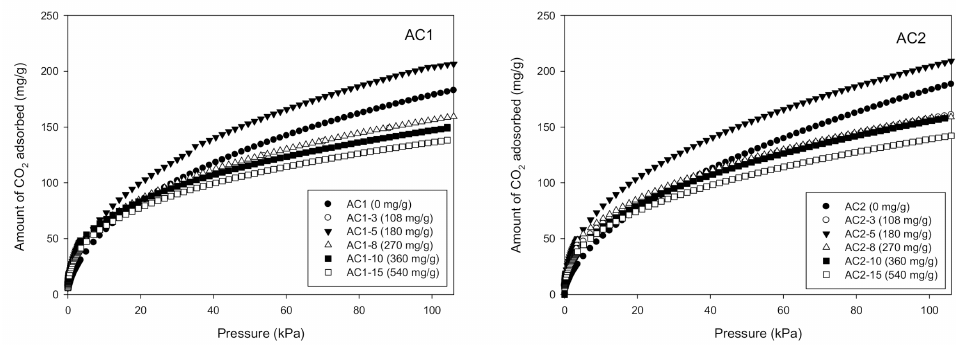
Figure 7. Isotherms of CO 2 adsorption at 273 K by coconut shell activated carbons, AC1 and AC2, impregnated with different amounts of sodium hydroxide (saturation pressure of CO 2 at 273 K is 3500